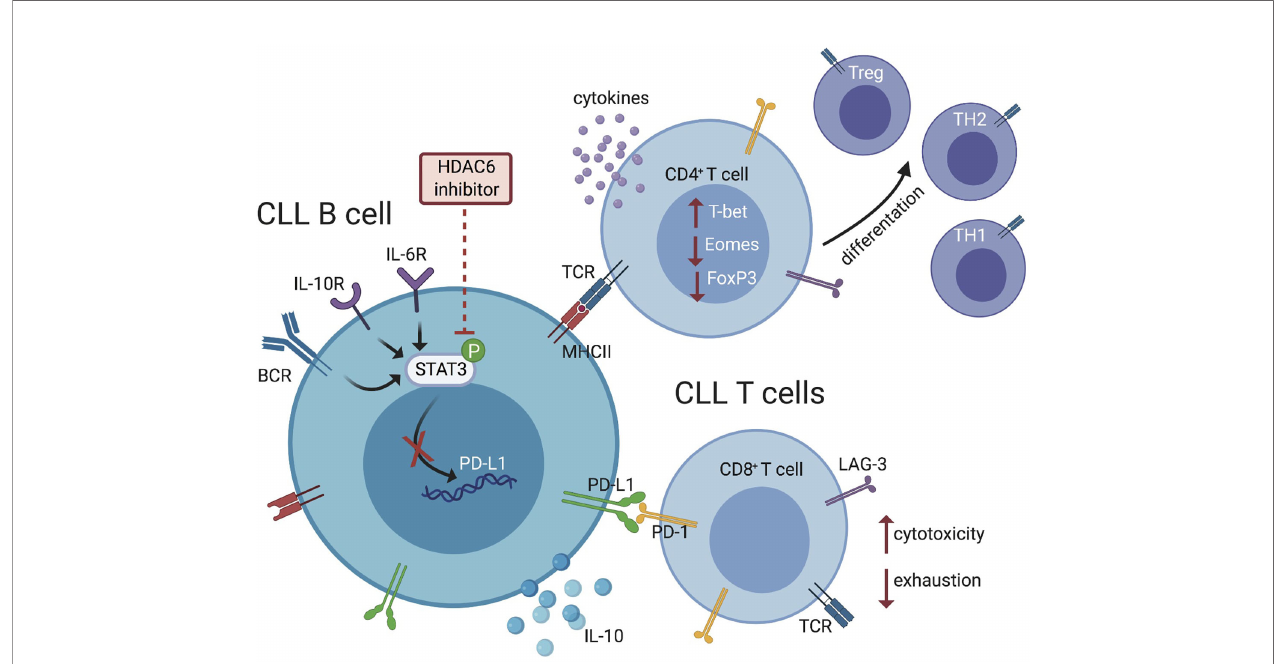
FIGURE 7 | Schematic representation summarizing the effects of HDAC6 inhibition on immunosuppressive mechanisms within the CLL microenvironment. HDAC6 inhibition disrupts regulatory CLL B-cell phenotype and function via JAK/STAT signaling, allowing T-cell activation and antitumor